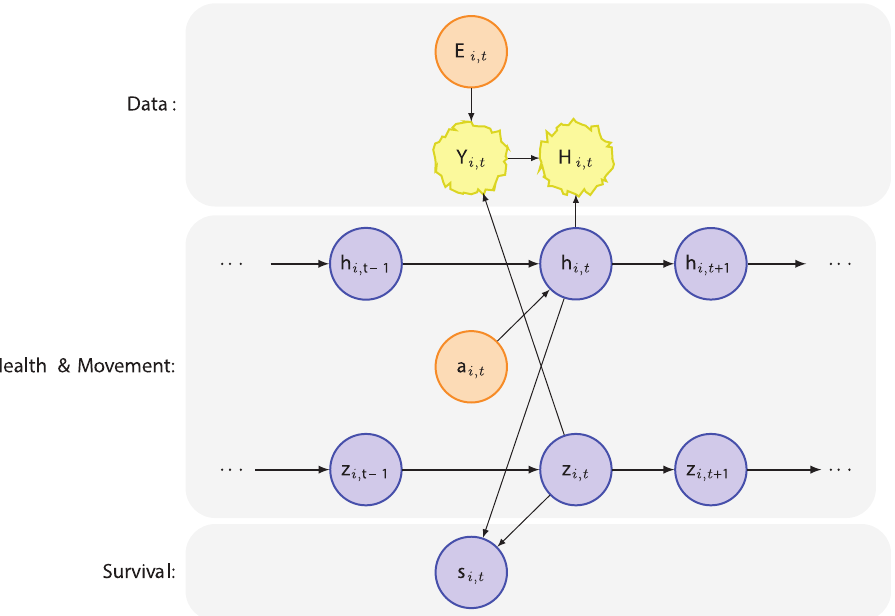
Figure 4. Graphical depiction of the statistical model. Graphical model depicting the dependency structure. We have observation models for the visual health parameters H , for survey effort E , and for sightings Y (top panel). The middle panel comprises two process models for the latent states of health h , and movement, z . Lastly, survival, s , is estimated as a function of latent health and movement.